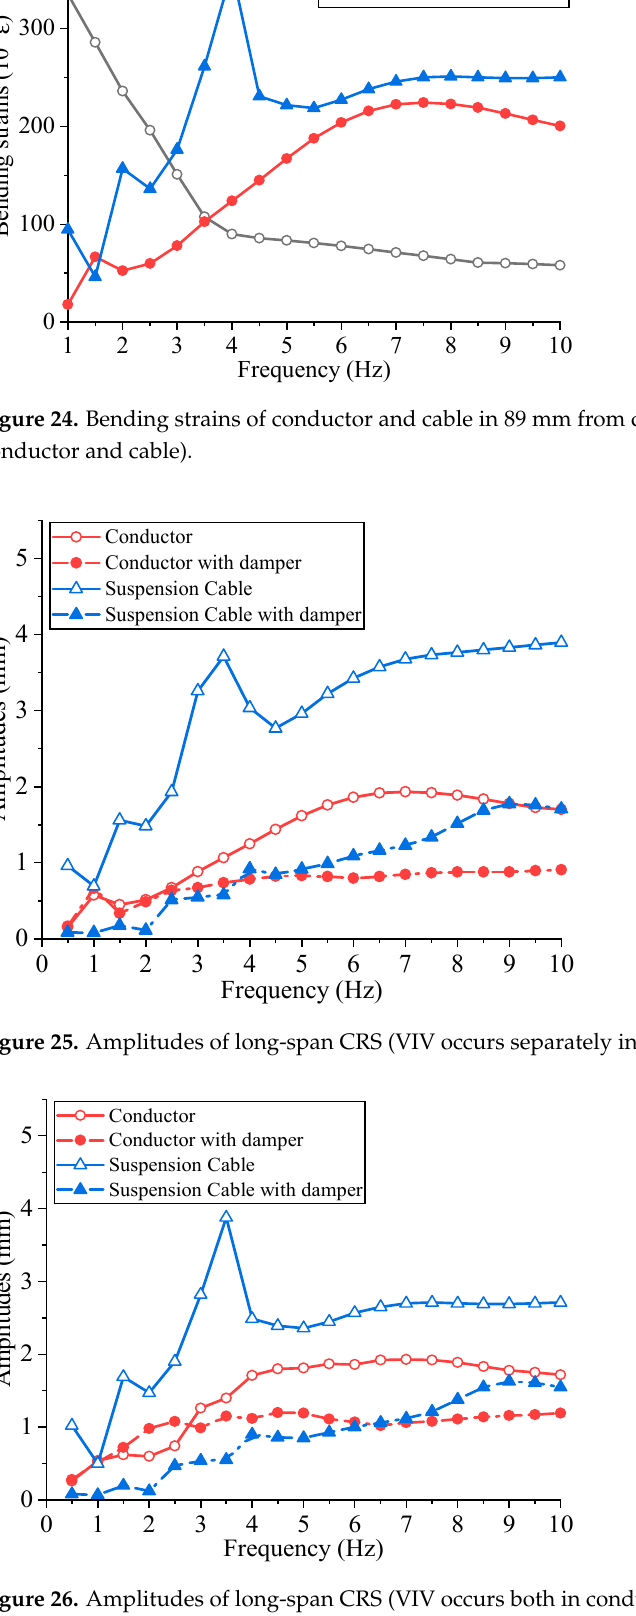
Figure 24. Bending strains of conductor and cable in 89 mm from clamp exit (wind load applied on conductor and cable).